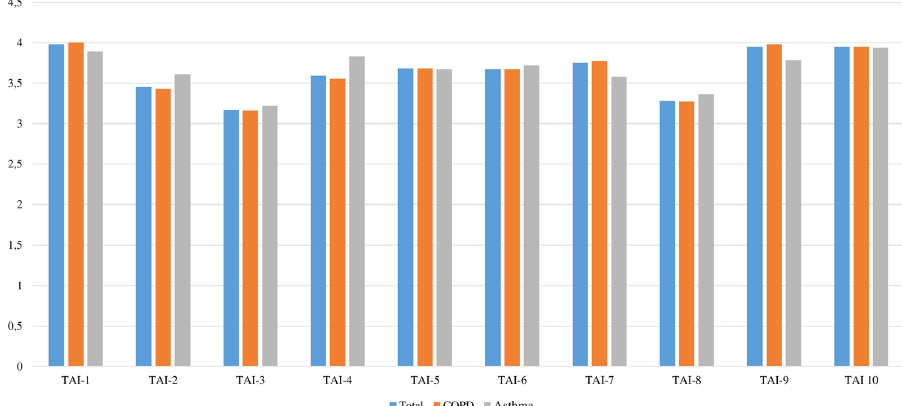
Fig. 2 The mean scores of the individual barriers to medication adherence (10-item TAI). *TAI-1- the frequency of forgetfulness in the last 7 days; TAI-2 – forgetfulness generally; TAI-3 – stop taking inhalers when feeling well; TAI-4 – stop taking inhalers due to holidays; TAI-5 – sadness; TAI-6 – side effects; TAI-7 – belief of little help of inhalers; TAI-8 – deliberate taking fewer inhalations than prescribed by the doctor; TAI-9 – belief that inhalers interfere with day-to-day or work life; TAI-10 – fi nance